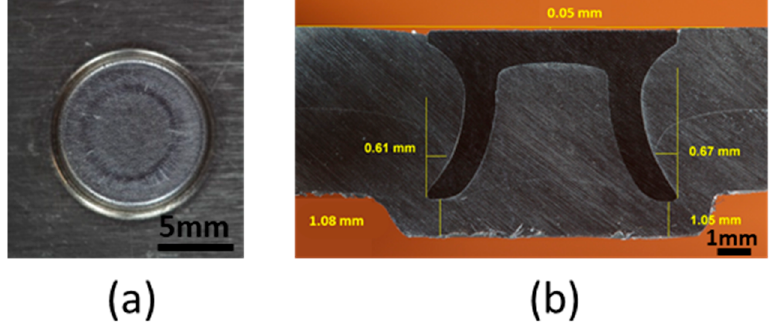
Figure 5. An acceptable joint made using a die with a diameter of 10 mm and depth of 1.4 mm, and a rivet with a length of 6.5 mm and hardness of 460 Hv with a velocity of 345 mm/s. ( a ) The surface quality of the riveting point in the bottom sheet, and ( b ) the cross section of the joint. To evaluate the strength of the joint, acceptable joints were examined by shear and peel tests.